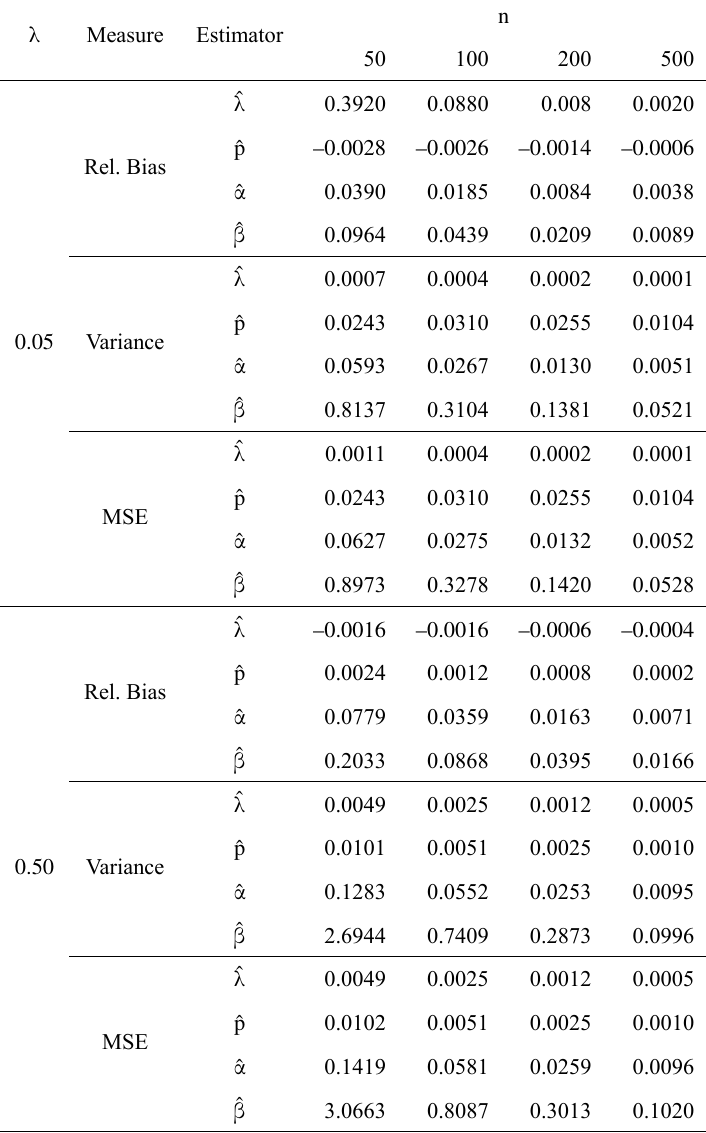
Relative biases, variances and MSEs of the maximum likelihood estimators of the parameters that index the ZOIK distribution; p = 0.5, α = 1.5, β = 3.0p = 0.5, α = 1.5, β = 3.0p = 0.5, α = 1.5, β = 3.0